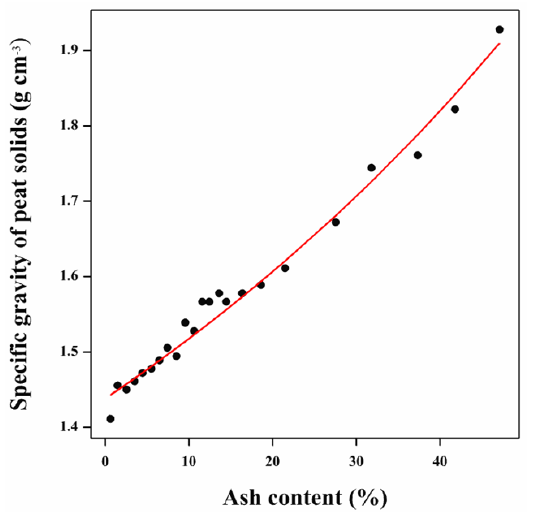
Figure 2. Increase in specific gravity of peat solids with ash content; data of Karesniemi (1972).